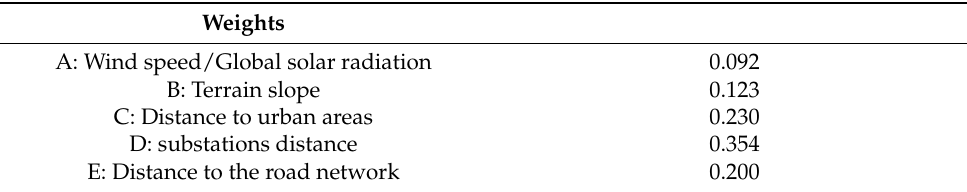
Table 8. Criteria weights.